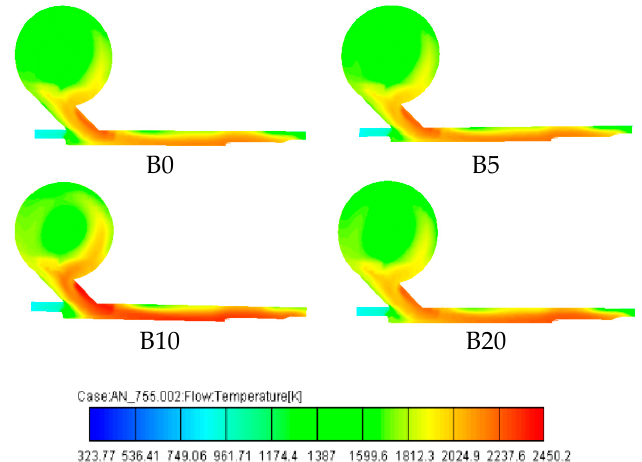
Figure 14. The progress of in-cylinder temperature (K) at 15° ATDC at 1400 rpm and 100% load.